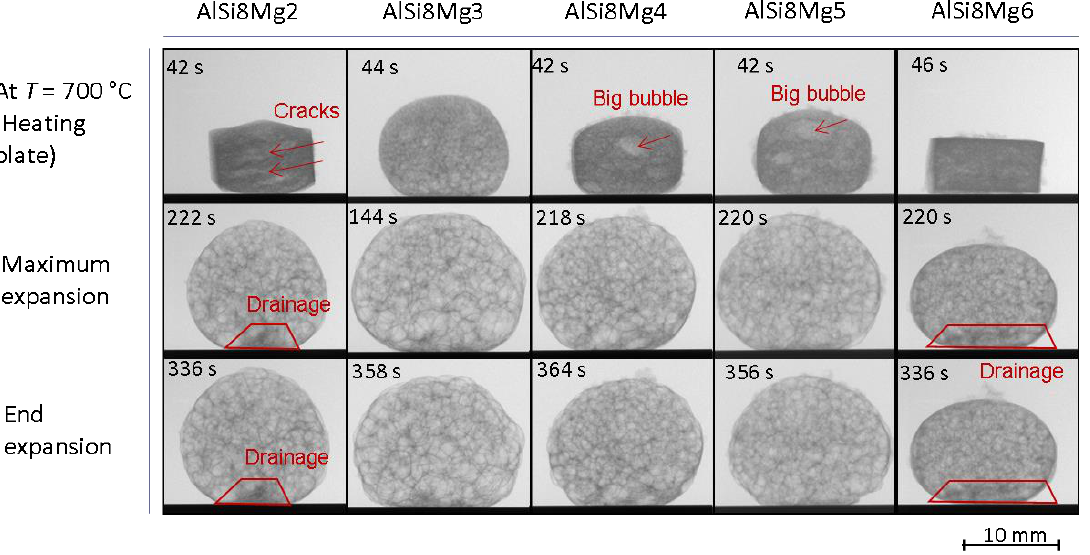
Figure C1. X-ray radiographies of evolving liquid metal foams of compositions AlSi8Mg Y ( Y = 2 6 wt.%) extracted from an in situ radioscopic series.